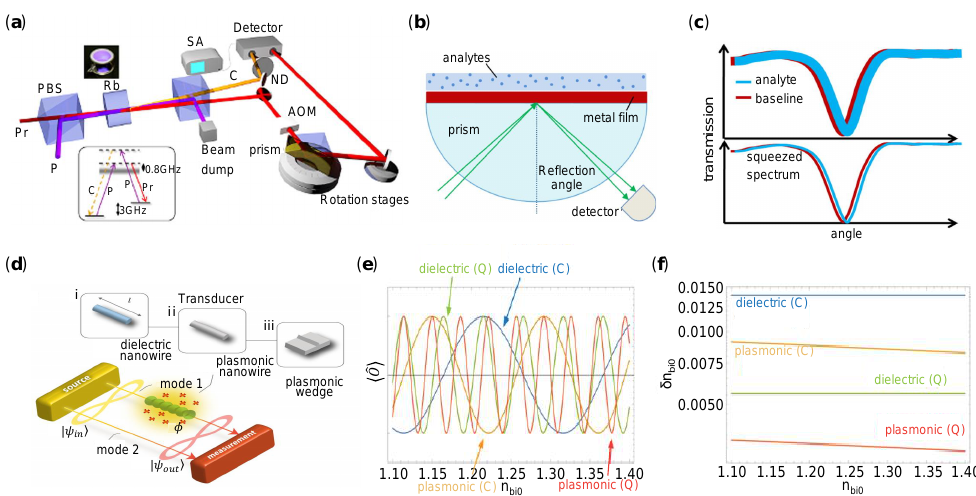
Figure 12. Quantum plasmonic intensity and phase sensors. ( a ) Experimental setup for sub-shot noise limit (SNL) plasmonic sensing. The inset shows the four-wave mixing scheme in Rb vapor. Two beams with different colors are used for probe (red) and reference (orange). ( b ) Schematic of Kretschmann SPR sensors with angular modulation. ( c ) Illustration of noise suppression via quantum-enhanced technology. ( d ) Schematic of two-mode interferometer with one arm in a nanowire waveguide. ( e ) Expectation values optimized for classical and quantum sensors. ( f ) Minimum resolution for classical and quantum sensors. Reprinted ( a – c ) with permission from Reference [241].